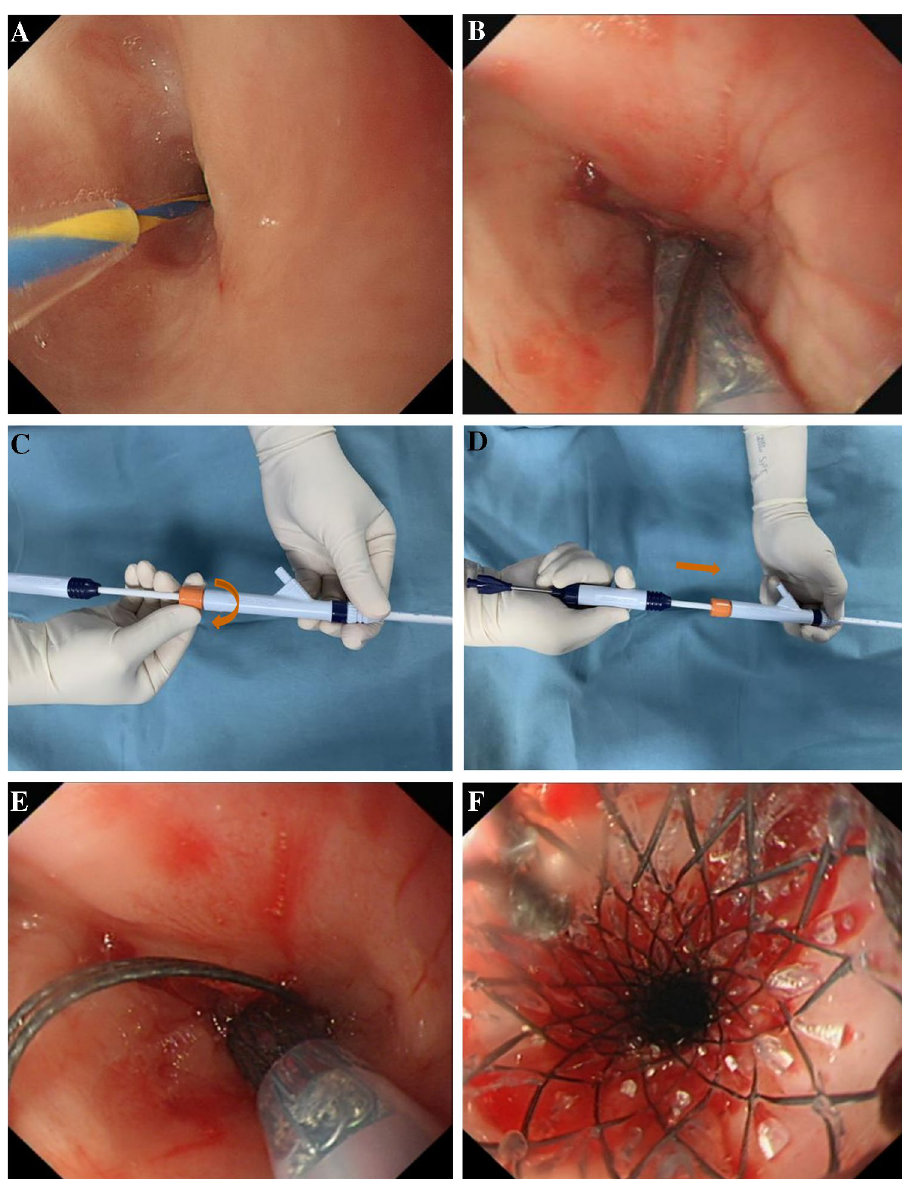
Figure 2. Illustration of fully covered self-expandable metal stent replacement. ( A ) Endoscopic view of the preoperative stricture with the zebra super-hard guide wire inserted into the stomach; ( B ) Under the guidance of the guidewire, FCSEMS was delivered to the stricture site through the stent delivery device; ( C , D ) Opening the safety lock and pushing the rear handle forward slowly to release the stent; ( E , F ) The stent was released and the lumen enlarged after FCSEMS